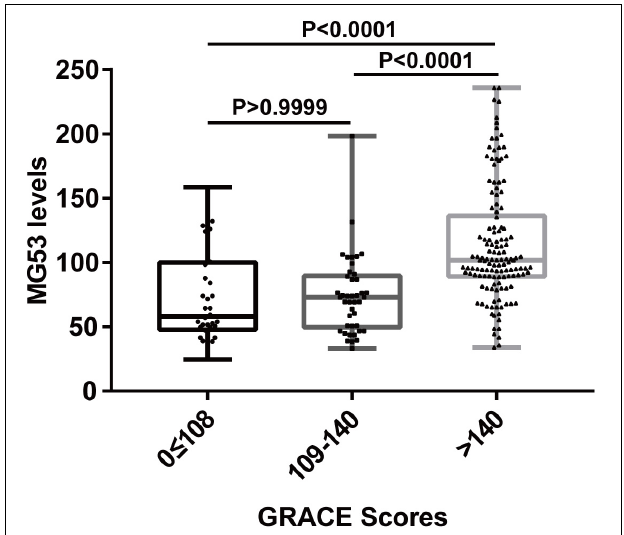
FIGURE 2 | Serum MG53 levels in different groups stratified by GRACE score. The patients with AMI were divided into three groups according to their GRACE scores. Patients in the 3rd groups showed the highest MG53